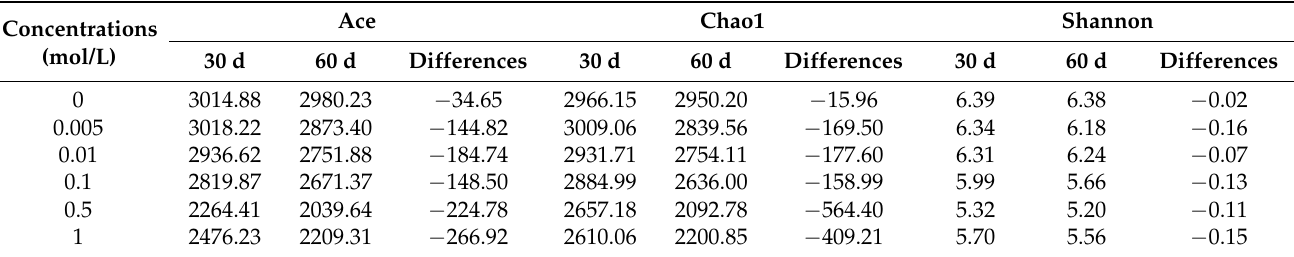
Table 2. Effect of catechol on bacterial diversity.